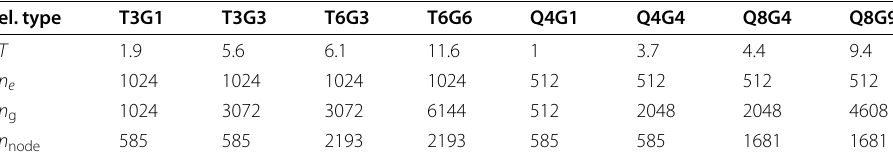
Table 3 Computing times T relative to the fastest discretization (Q4G1) for h = 2 (cid:4) , number of macroscopic elements n e , Gauss integration points n g , and nodes n node el. type